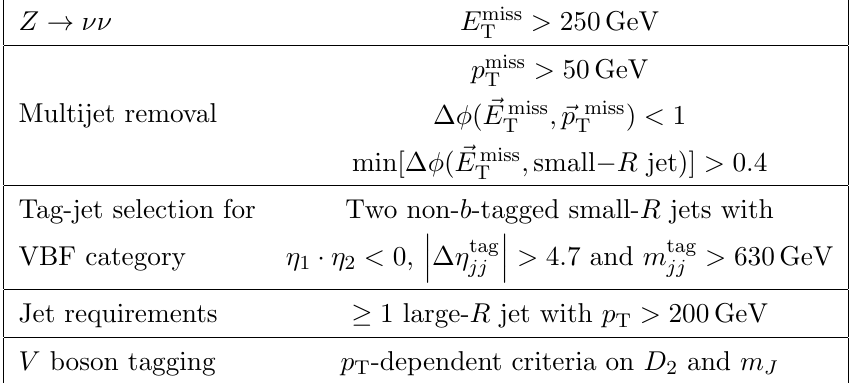
Table 3 . Summary of the X